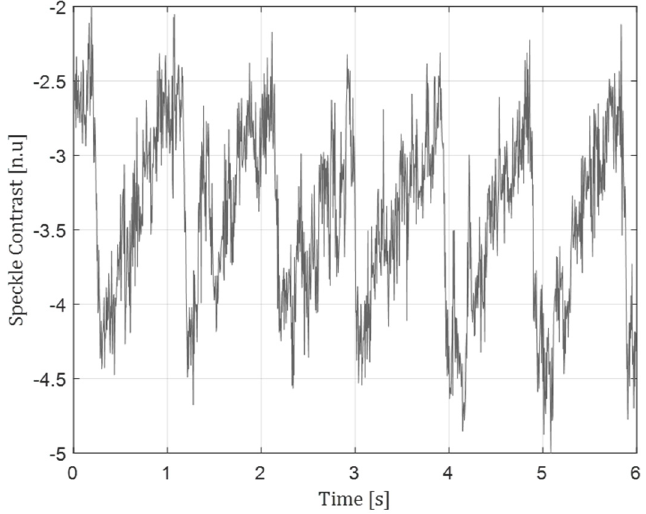
Figure 6. Blood flow signal reconstruction.